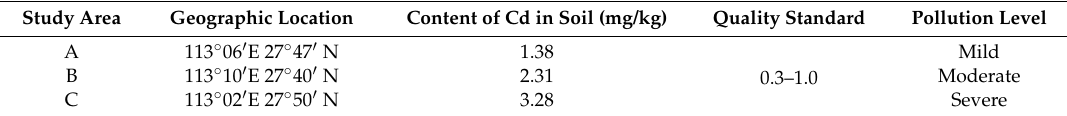
Table 1. The pollution levels of the heavy metal cadmium (Cd) in the three study areas.